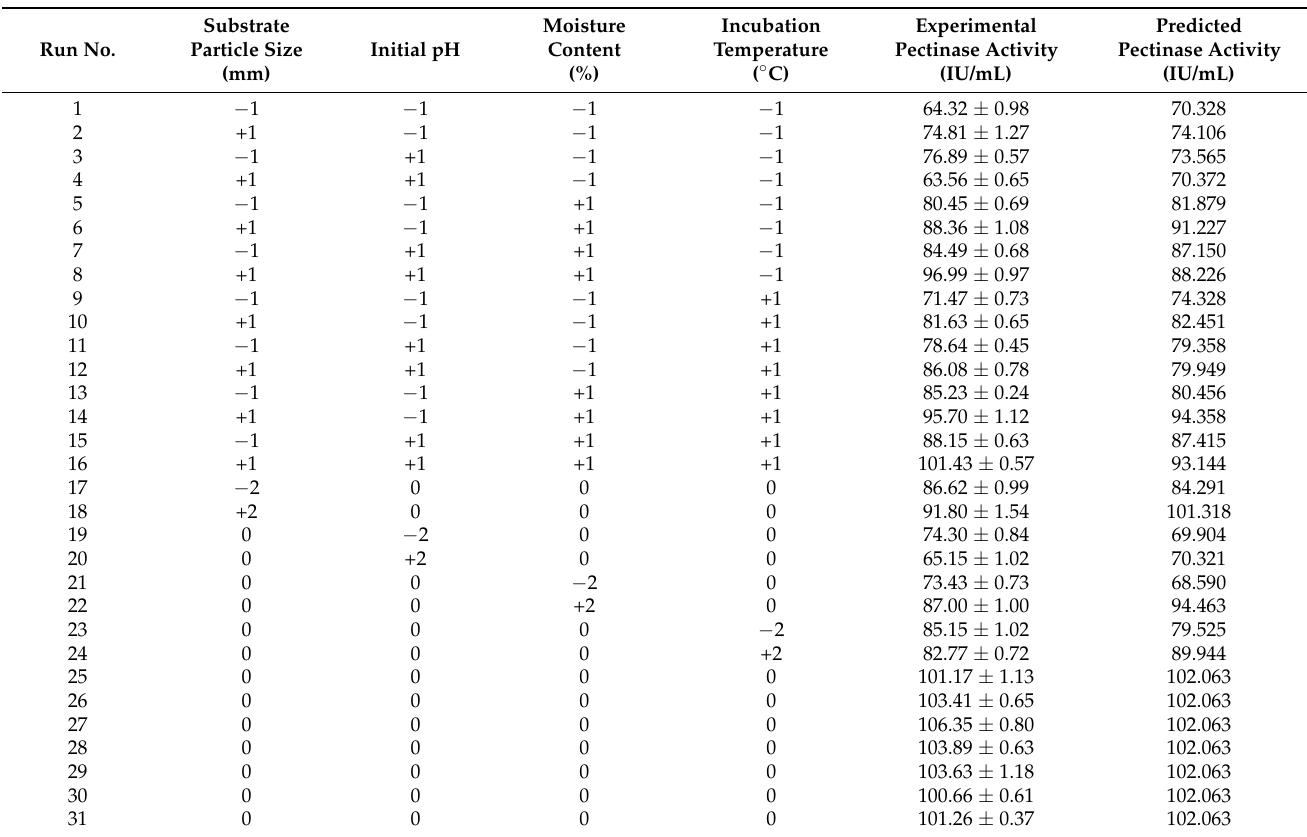
Table 2. CCD matrix for process